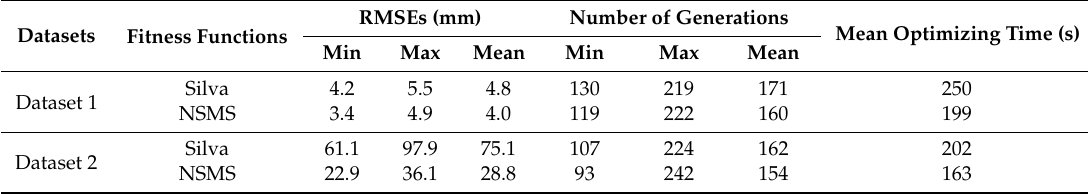
Table 5. The accuracy and efficiency of different fitness